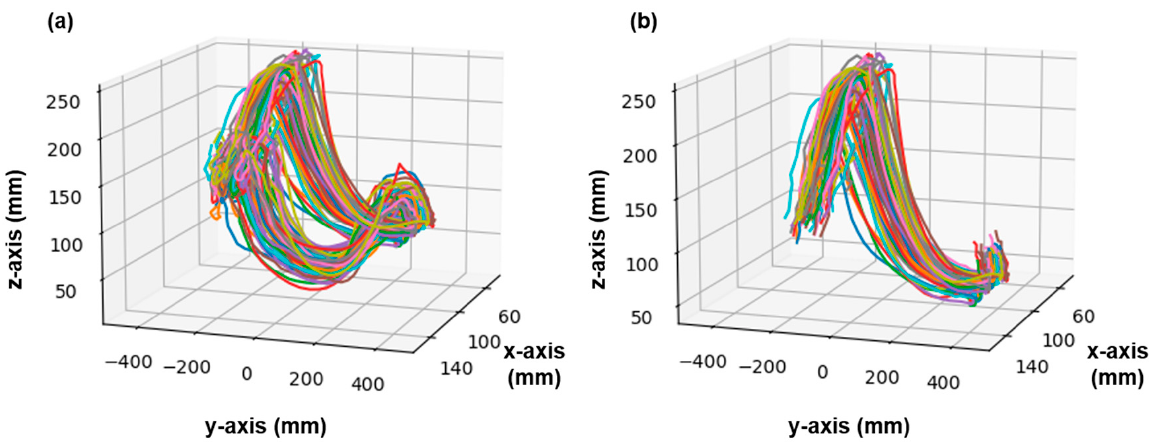
Figure 6. Foot trajectory estimation using UWB sensors: ( a ) All the foot trajectory results; ( b ) Only the results estimated in the swing phase.